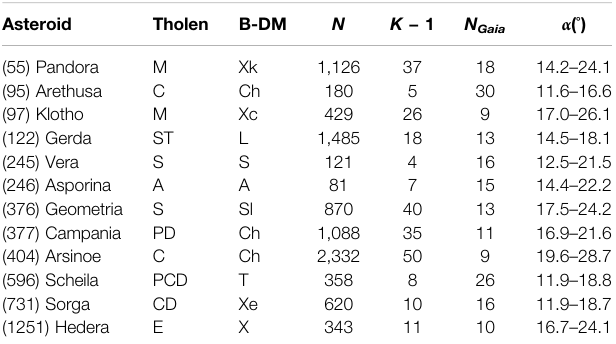
TABLE 1 | Example asteroids with photometry in Gaia Data Release 2. Tholen stands for the Tholen taxonomic class, B-DM stands for the Bus-DeMeo taxonomic class, N is the total number of Gaia and ground-based observations, K − 1 is the number of observed ground-based lightcurves, N Gaia is the number of observed Gaia points, and α denotes the phase angle coverage for each asteroid using Gaia data.